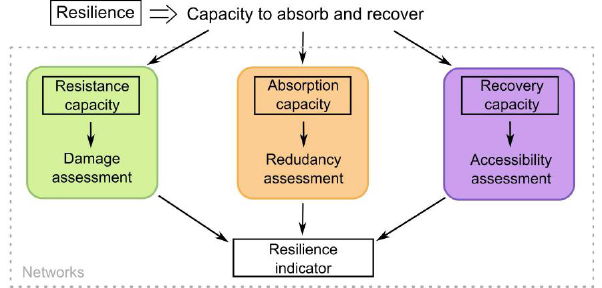
Figure 1: Strategy for assessing networks 2 resiliency